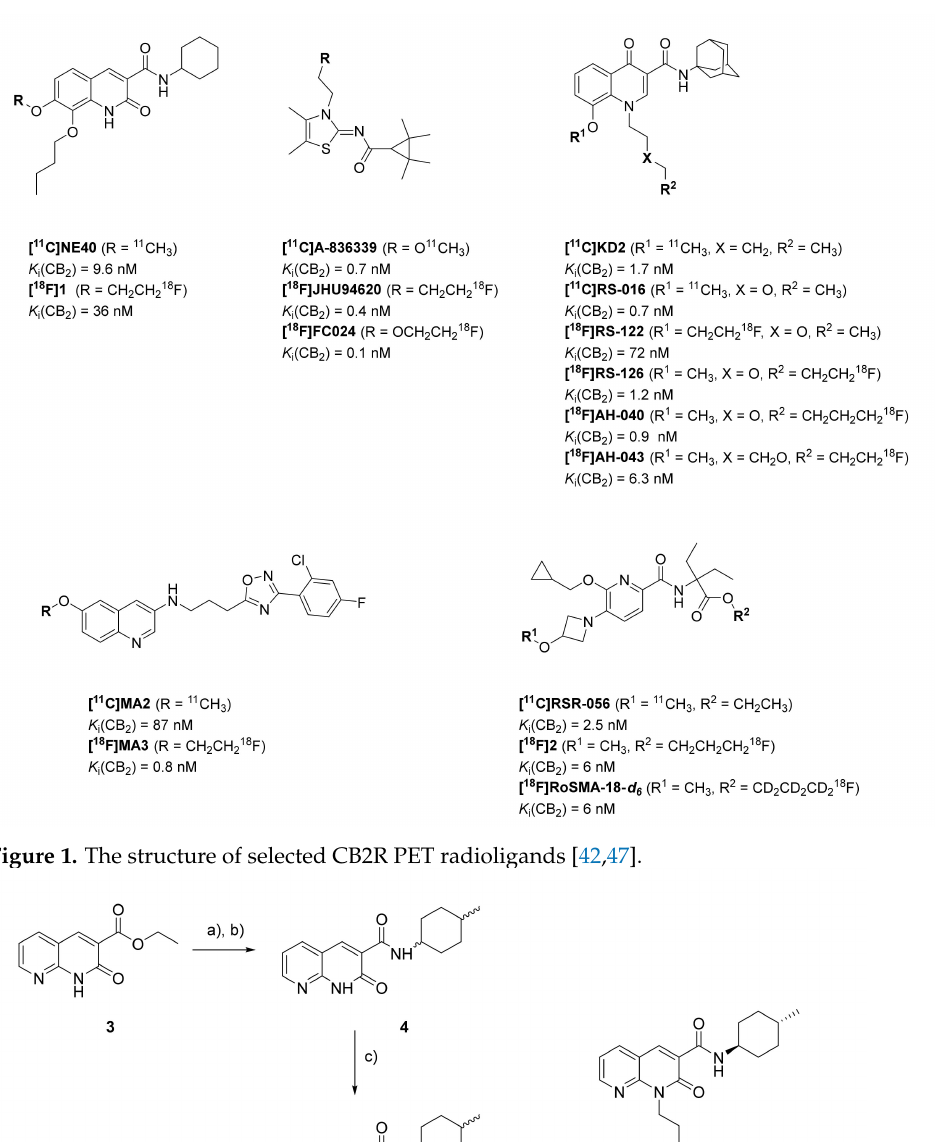
adeno-associated viral (AAV2/7) vector expressing hCB2R(D80N) at high densities in a striatal region [50,67,68].